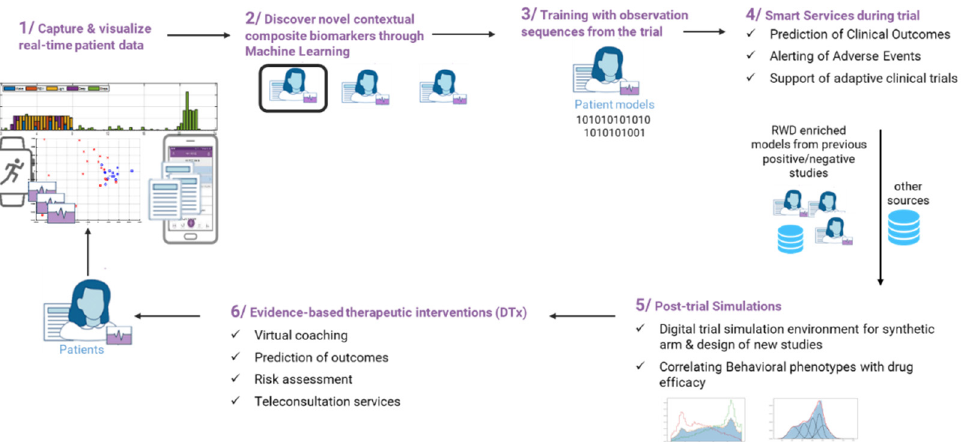
Figure 3. The lifecycle of RWD in Healthentia.